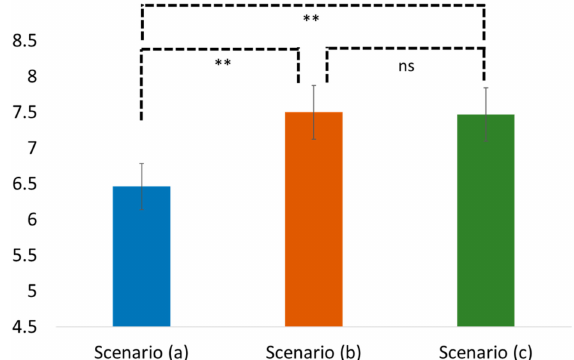
Figure 5. Comparison of the health-friendly Buddhist practice in di ff erent scenarios. Note: ns stands for non-significant; ** means < 0.05.